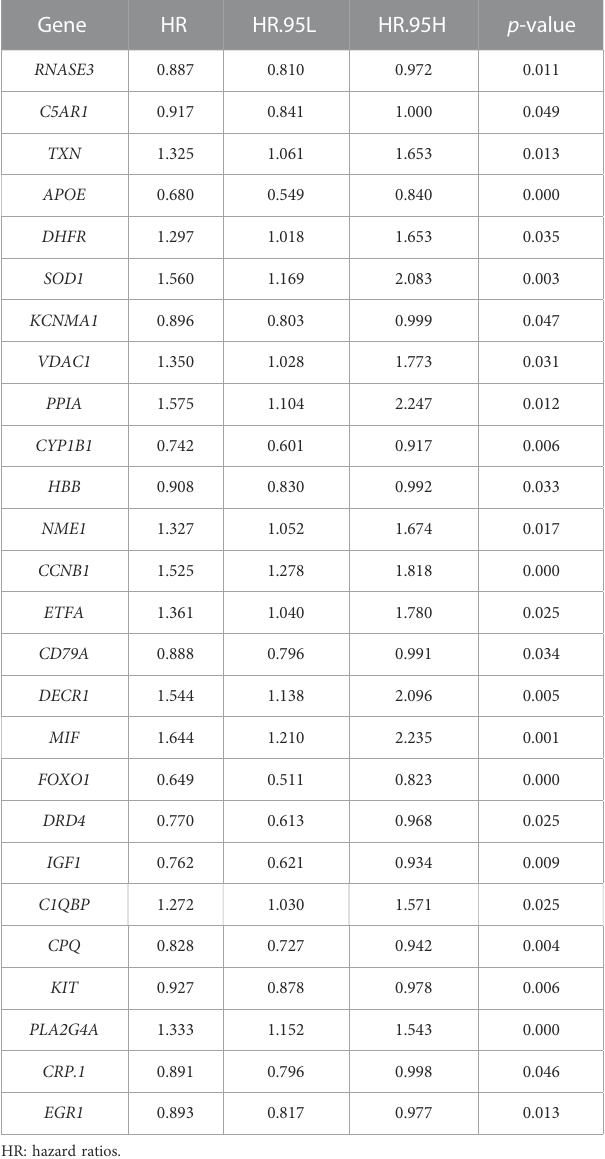
TABLE 1 26 potential genes based on univariate Cox regression analysis.